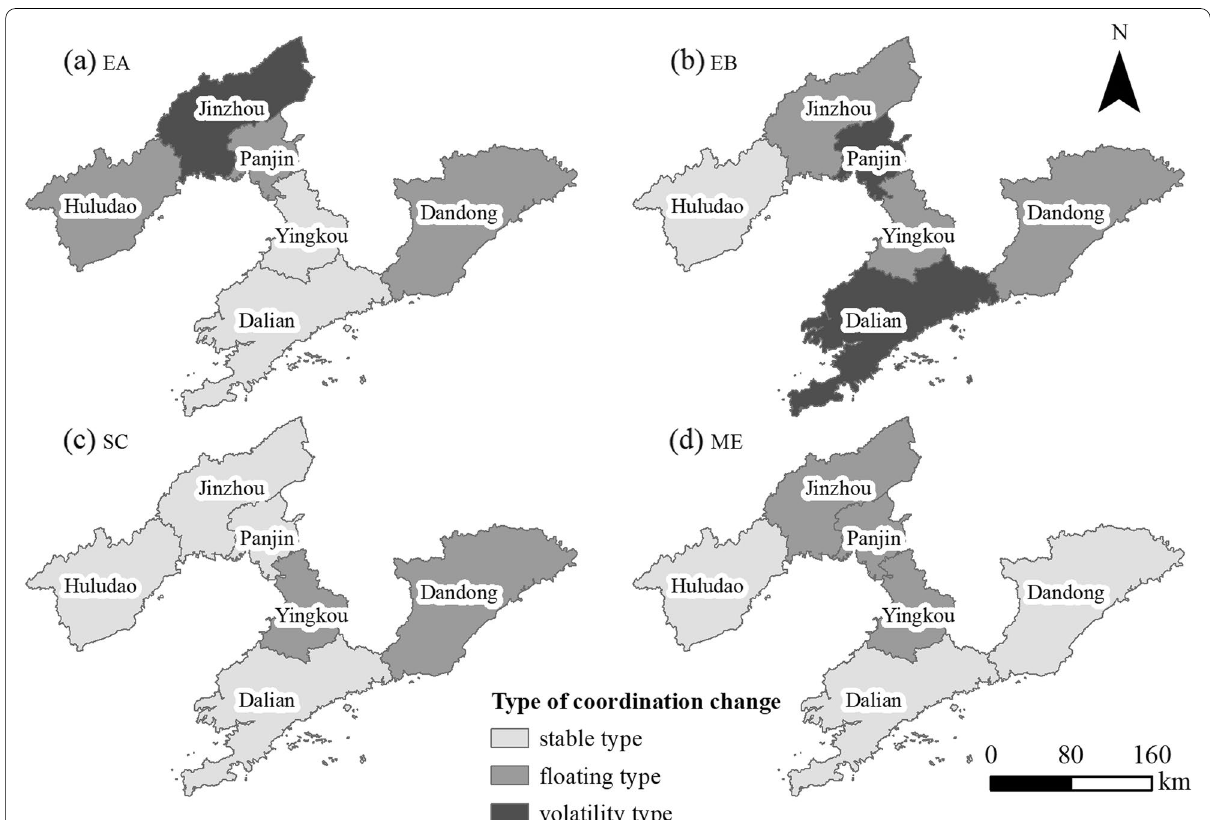
Fig. 5 Variation types of spatiotemporal coordination degree of comprehensive evaluation of the marine governance efficiency of the six coastal cities in Liaoning from 2004 to